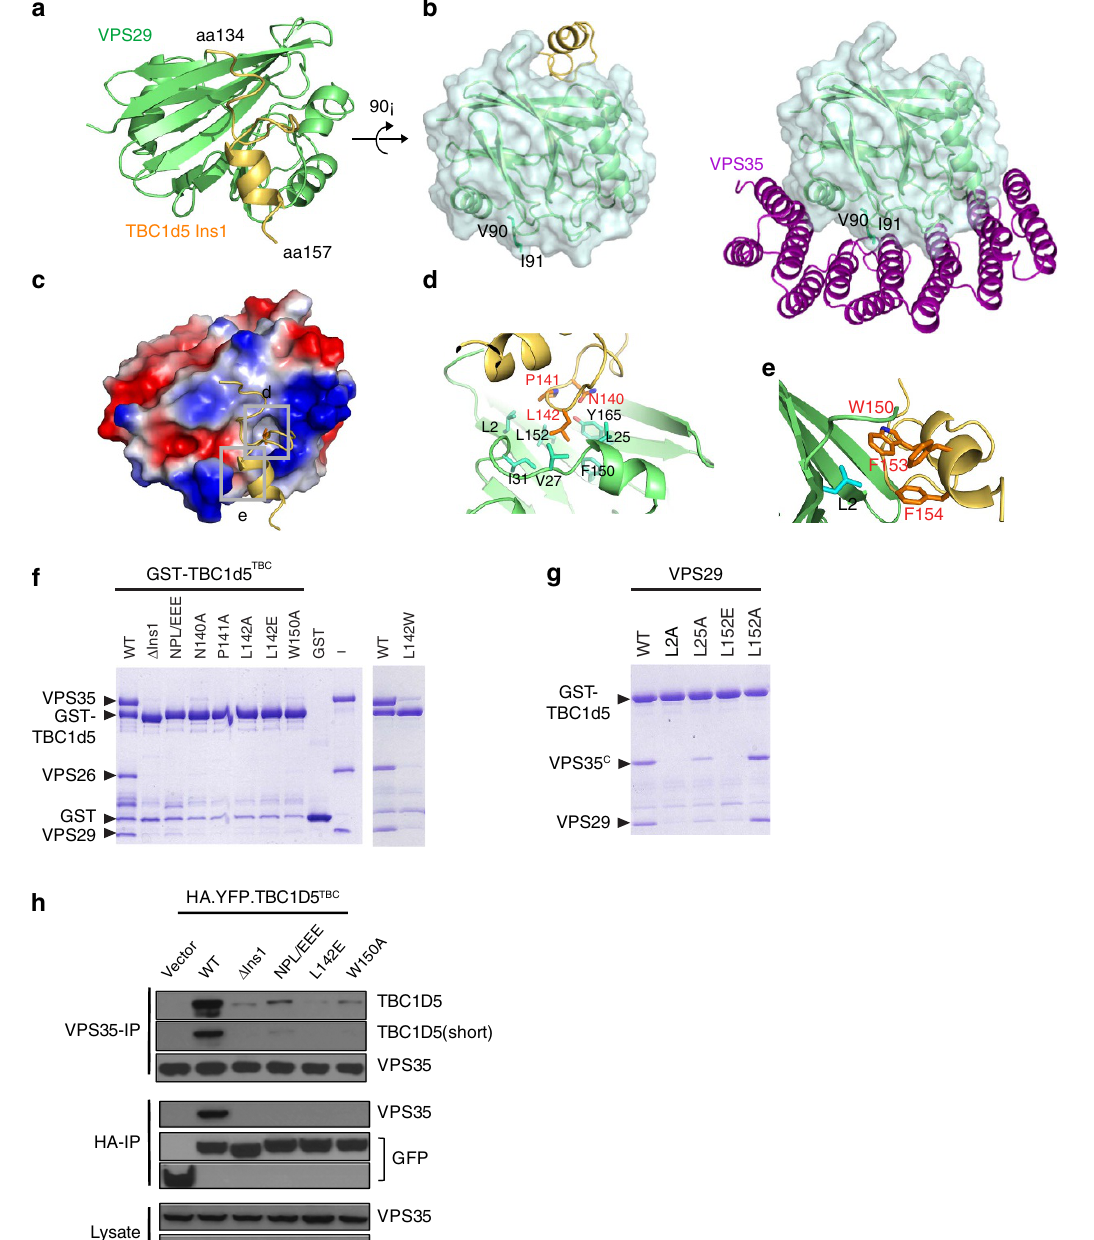
surfaces of VPS29 (Fig. 2b,c). Residues 134–157 are represented by clear electron density in the structure (Supplementary Fig. 4). The Ins1 peptide can be divided into three distinct regions based on secondary structure (Fig. 2c): the N-terminal part (residues 134–137) forms an unstructured coil, the middle region (aa 138–148) makes multiple sharp turns on the VPS29 surface